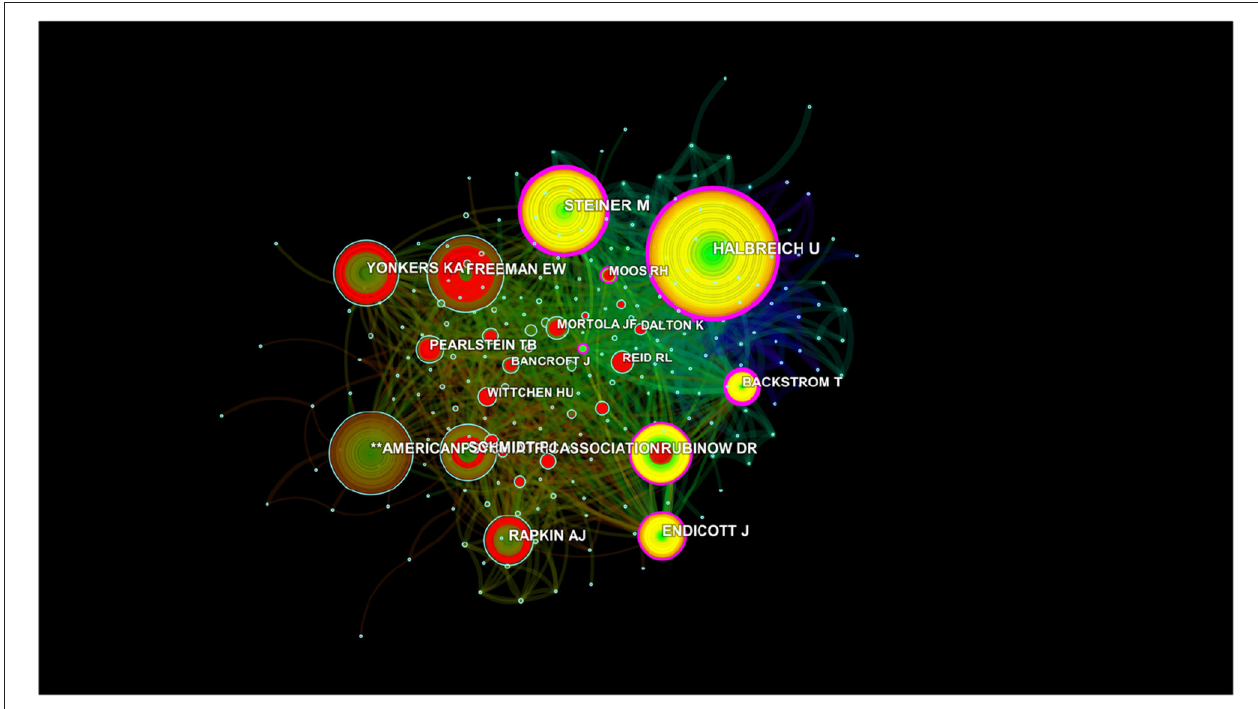
FIGURE 7 | Map of co-cited authors that published articles on PMS/PMDD during